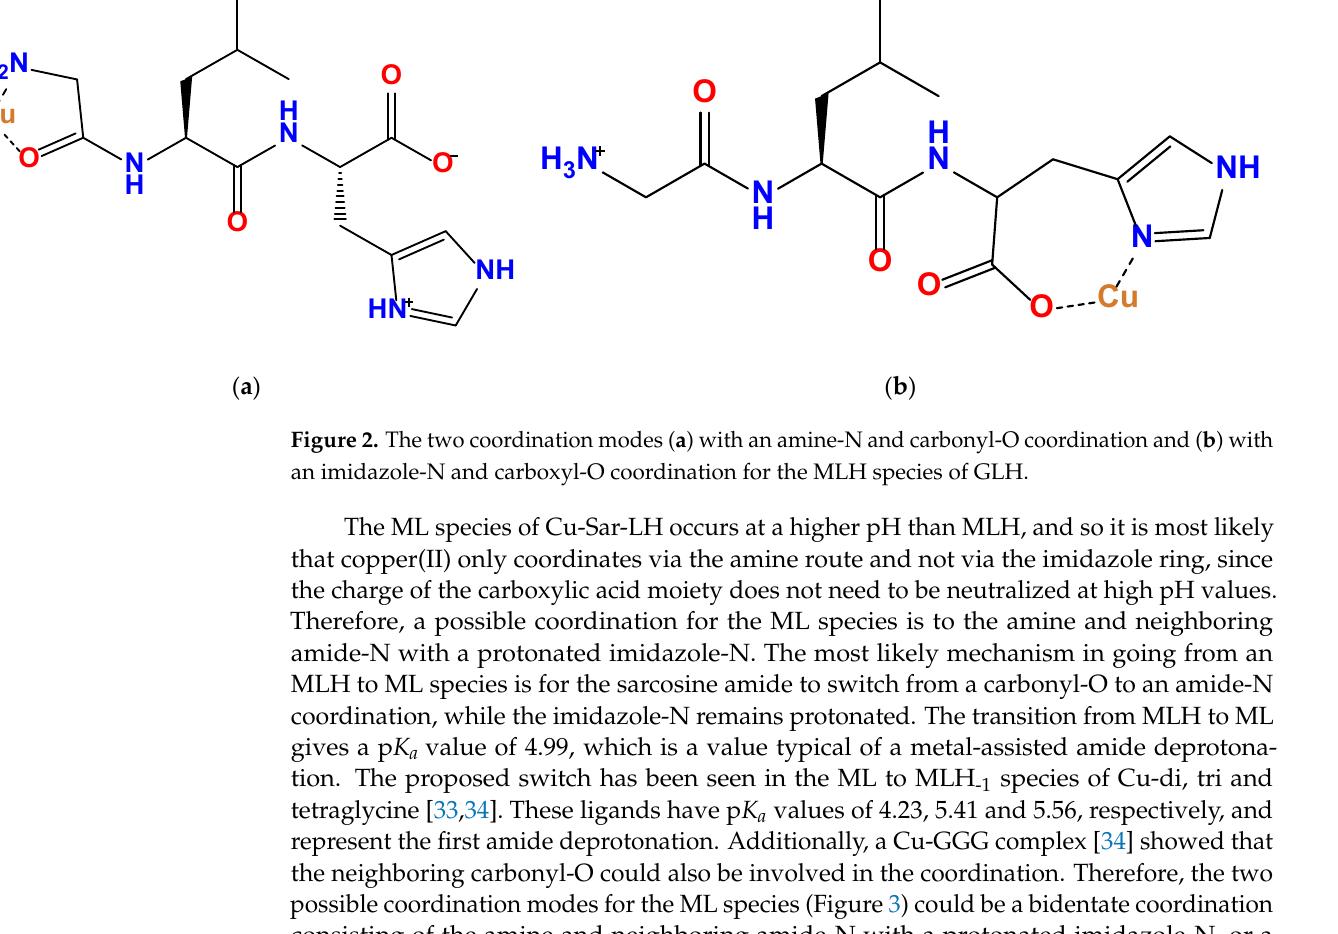
( b ) Figure 3. The two coordination modes ( a ) with an amine-N and neighboring amide-N coordination and ( b ) with an amine-N, neighboring amide-N and carbonyl-O coordination for the ML species of Sar-LH.